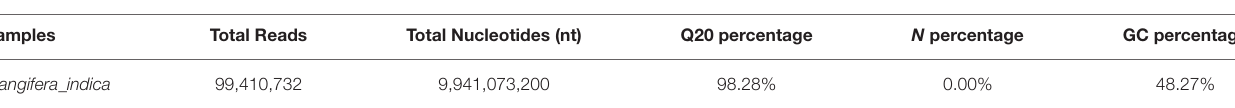
TABLE 1 | Output statistics of